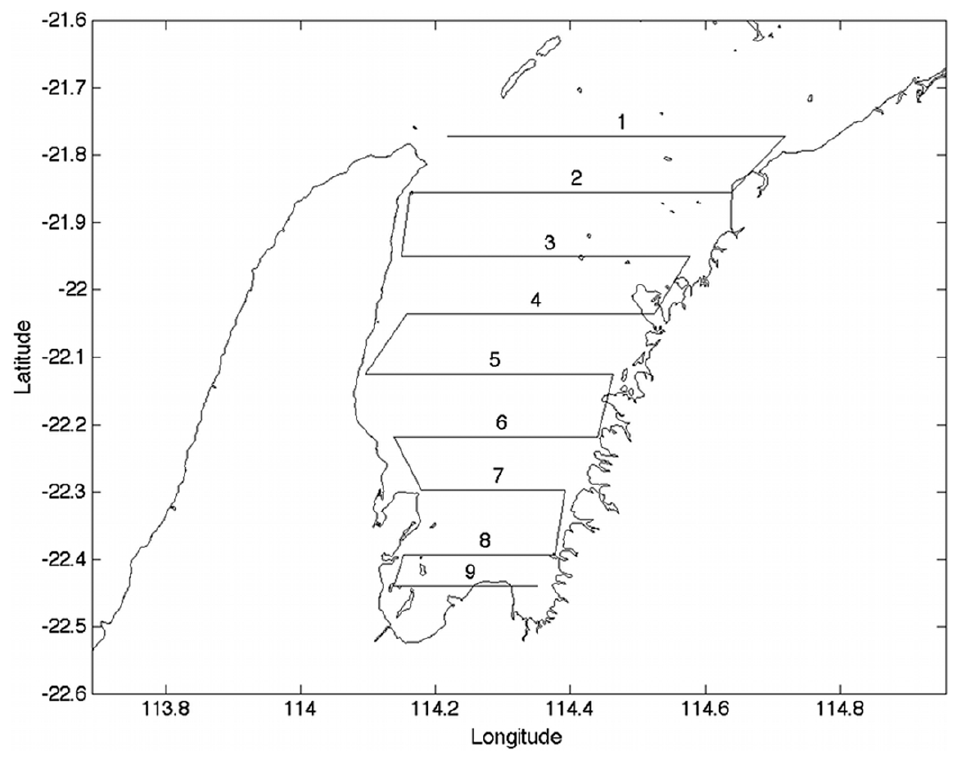
Figure 1. The aerial survey track over Exmouth Gulf. A typical course flown by the aircraft during surveys. This flight path was split into nine parallel transects spaced approximately 10 km apart.